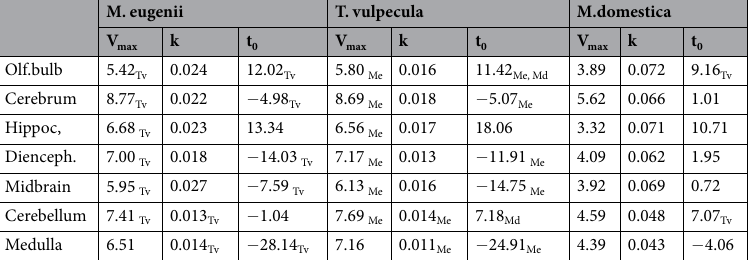
Table 3. Partition growth curve parameters of natural logarithm growth curves in the three species investigated. Vmax, maximum size estimate; k, growth rate; t0, day at which growth is estimated to have commenced. Species abbreviations in subscript denote parameters which are not significantly different compared to the other species (e.g. t 0 of the olfactory bulb of T.vulpecula is not significantly different from that of M. eugenii and M. domestica ).